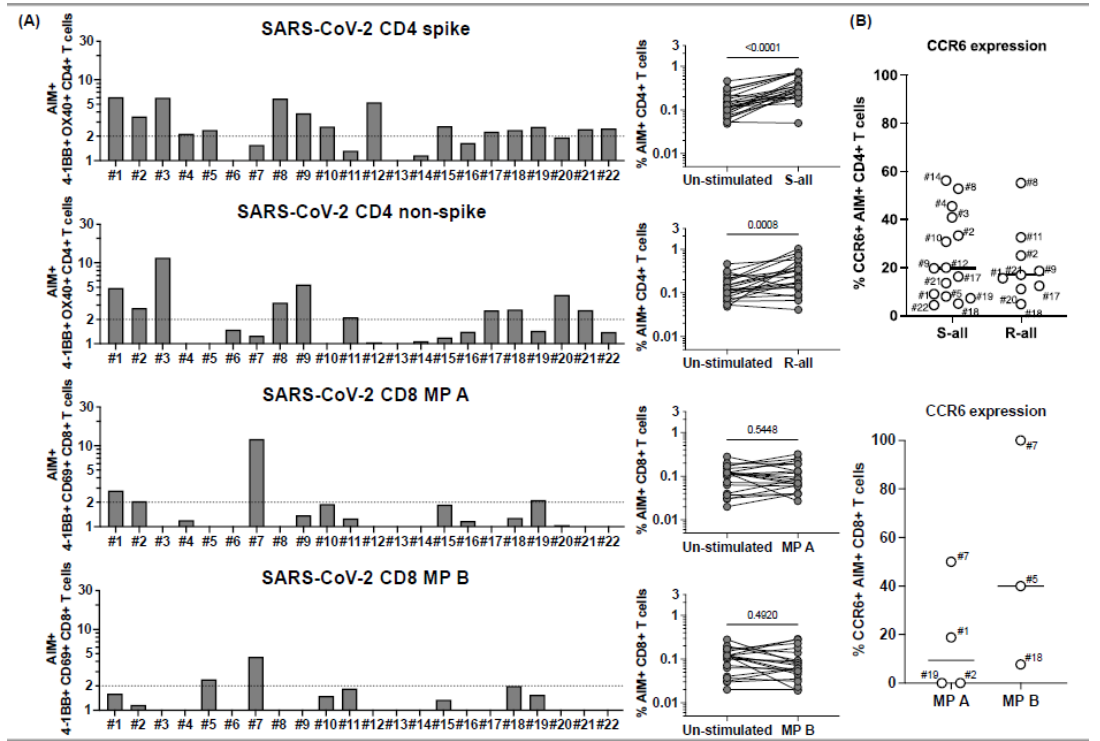
Figure 1. CD4+ and CD8+ T cell responses to peptide megapools derived from SARS-CoV-2 and their CCR6 expression in subacute MIS-C subjects. PBMCs from 22 subacute MIS-C subjects were separated from heparinized whole blood samples using Ficoll density gradient and stimulated with peptide megapools derived from SARS-CoV-2: CD4 spike (253 epitopes), CD4 nonspike (221 epitopes), CD8 MP A (314 epitopes), or CD8 MP B (314 epitopes). Cell preparations were collected 24 h after stimulation, followed by staining using monoclonal antibodies, to study the T cell activation in response to peptide megapool stimulations and the CCR6 expression on SARS-CoV-2-specific CD4+ and CD8+ T cells by flow cytometry. The T cell responses to the peptide megapools were calculated by dividing the percentage of activated T cells under different stimulatory conditions by the percentage of activated T cells in the unstimulated vehicle controls and were shown as stimulation index (SI). An SI ≥ 2 was considered a positive T cell response to the peptide megapool. ( A ) CD4+ and CD8+ T cell responses in responses to SARS-CoV-2 peptide megapools in individual subacute MIS-C subject. CD4+ T cell activation was defined by the coexpression of 4-1BB and OX40 (AIM+) gated under CD4+ T cells. CD8+ T cell activation was defined by the coexpression of 4-1BB and CD69 (AIM+) gated under CD8+ T cells. Five (1, 2, 5, 18, and 19) of the 22 subjects showed coordinate CD4+ and CD8+ T cell responses to SARS-CoV-2 CD4 and CD8 peptide megapools. Twelve subjects (3, 4, 8–12, 15, 17, and 20–22) of the 22 studied showed T cell responses to SARS-CoV-2 CD4 peptide megapools, and 1 (7) of the 22 subjects showed T cell responses to only SARS-CoV-2 CD8 peptide megapools. The T cell responses to SARS-CoV-2 CD4 and CD8 peptide megapools were not detected in 4 subjects (6, 13, 14, and 16) of the 22 subacute MIS-C subjects studied. Overall, CD4+ T cells from the MIS-C subjects showed more prevalent responses to SARS-CoV-2 CD4 spike ( p < 0.0001) and nonspike ( p = 0.0008) proteins, and CD8+ T cell responses were less prominent in the cohort ( p > 0.05 for both SARS-CoV-2 CD8 megapool MP A and MP B). ( B ) CCR6 expression on SARS-CoV-2-specific CD4+ (top panel) and CD8+ (bottom panel) T cells. CCR6 expression can be found on both AIM+ CD4+ (median: 17.8%; Q1–Q3: 9.54–33.1%) and AIM+ CD8+ (median: 18.8%; Q1–Q3: 0–50%) T cells, although the expression of CCR6 on AIM+ CD8+ T cells varies between subjects. Each symbol represents data derived from an individual subject. Comparisons of the percentage of AIM+ T cells between unstimulated control and peptide megapool-stimulated cell cultures were tested by the Wilcoxon signed-rank